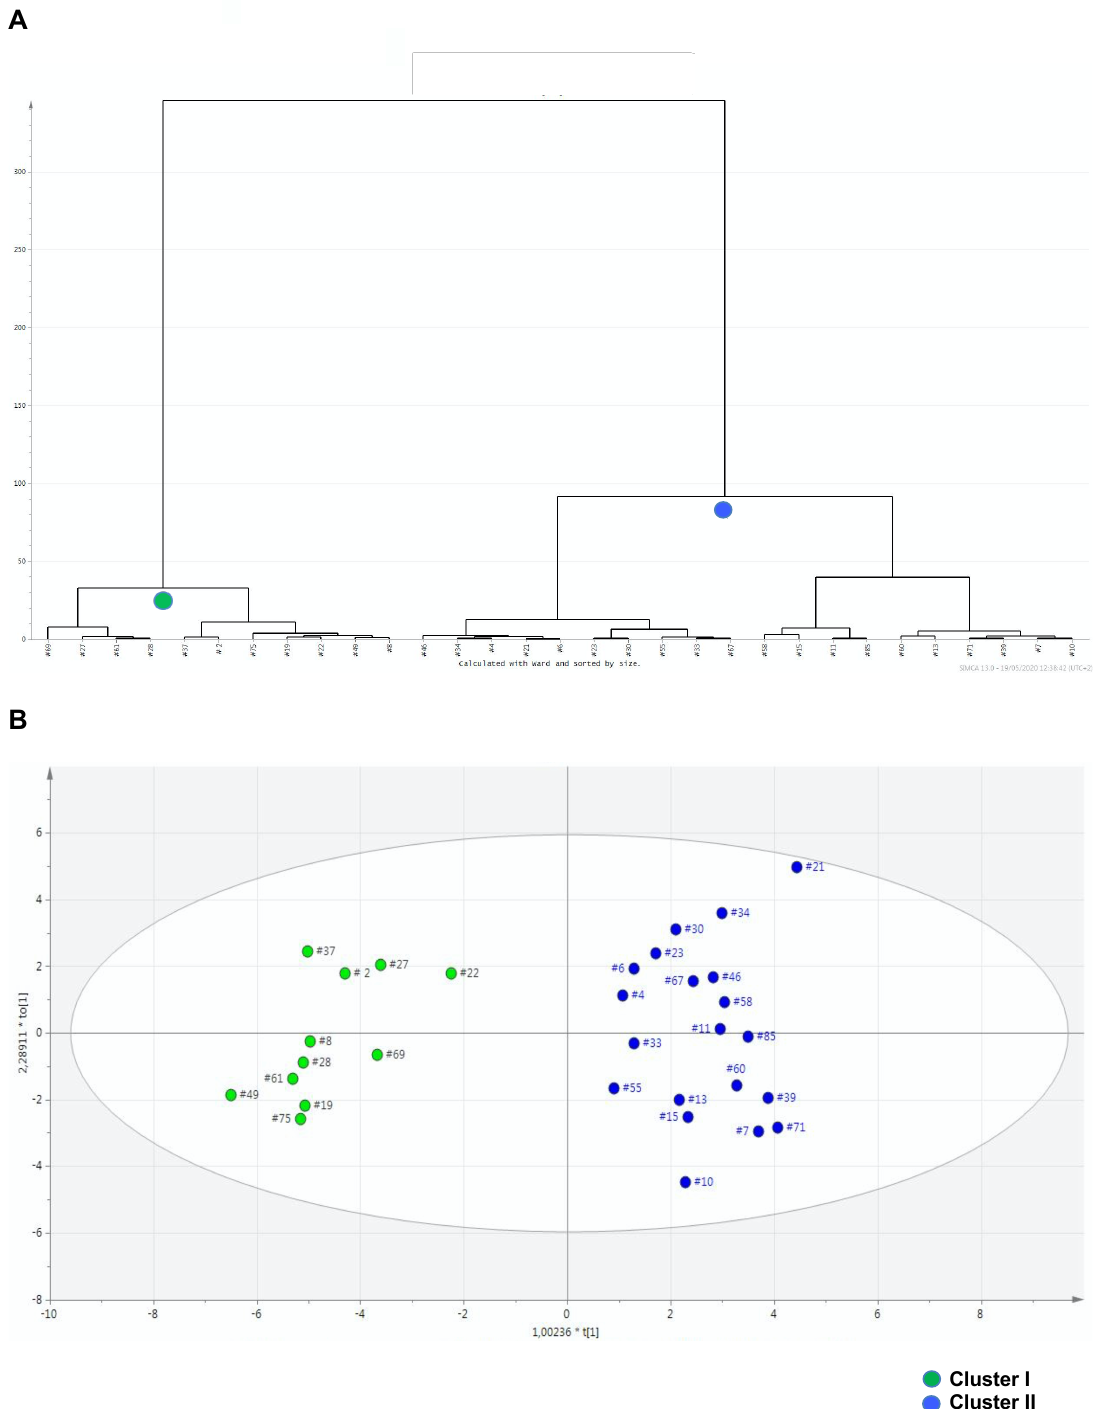
Figure 4. Hierarchical cluster analysis (HCA) represented by the dendrogram plot ( A ); the horizontal lines depict the grouping of clusters and the distance between two joining clusters, the vertical lines represent the di ff erences of these distances. OPLS-DA scatter plot ( B ) of the first principal component obtained from GC-MS spectra of urine samples from cluster I (green dots, n = 11) and cluster II (blue dots, n = 20). Both dendrogram and OPLS-DA scatter plot report the identification number for each urine metabolome. Clusters I and II were obtained by HCA, as depicted by the